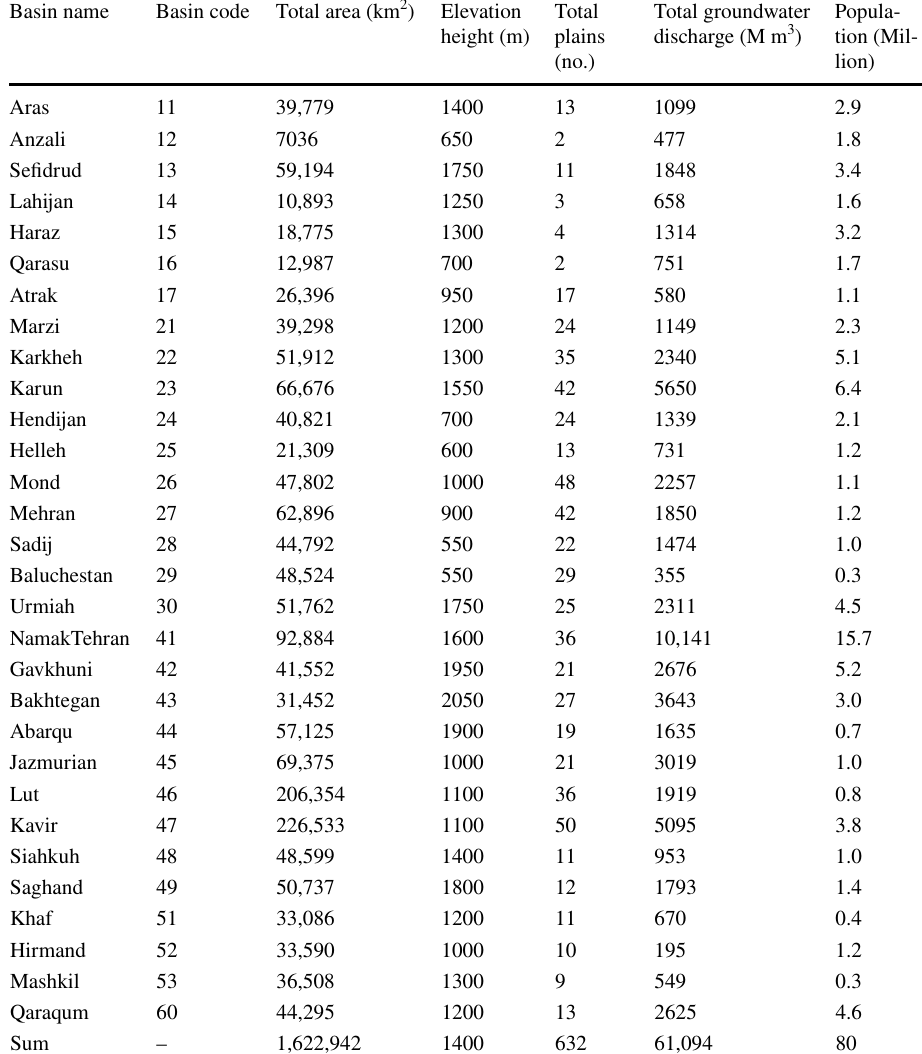
Table 1 General names, codes, statistics, and physical data of 30 major hydrological basins in Iran (after WRM